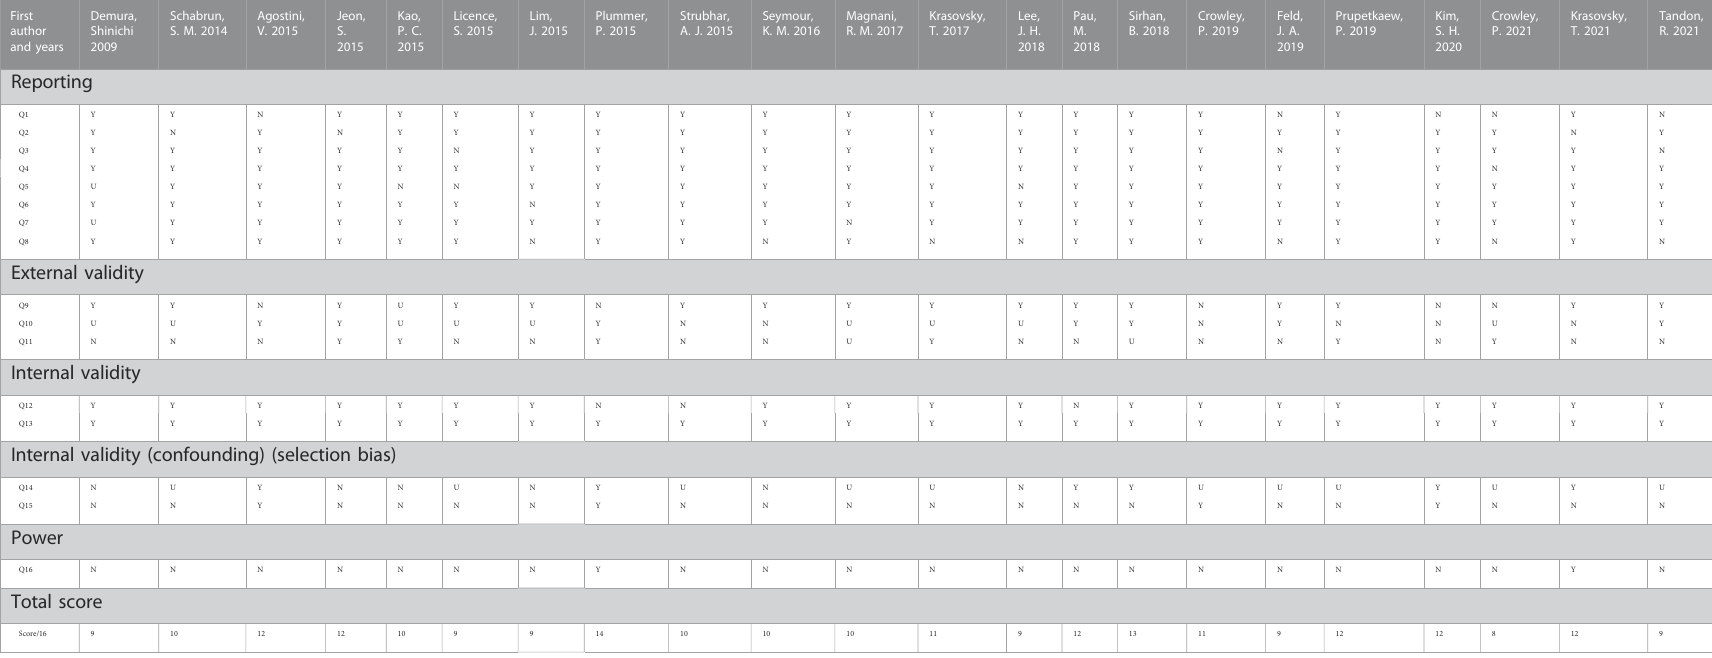
TABLE 2 Methodological quality assessment for inclusion in the study according to downs and black